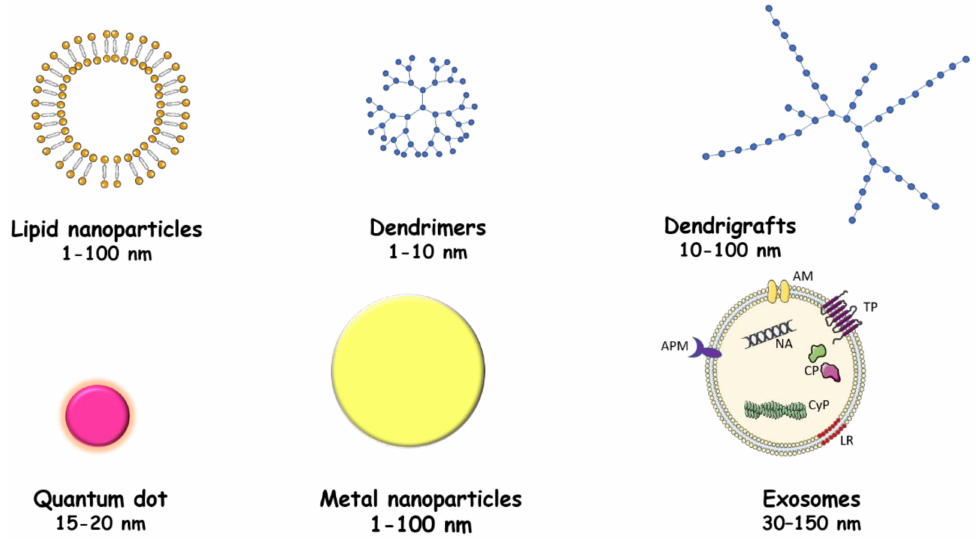
Figure 3. Representation of different delivery systems for therapeutic molecules. Different systems are used to deliver therapeutic molecules: lipidic nanoparticles, dendrimers and dendrigrafts, quantum dots and metallic nanoparticles, and exosomes. AM: adhesion molecules; TP: transmembrane proteins; APM: antigen presenting molecules; NA: nucleic acid; CP: cytosolic proteins; CyP: cytoskeletal proteins; LR: lipid